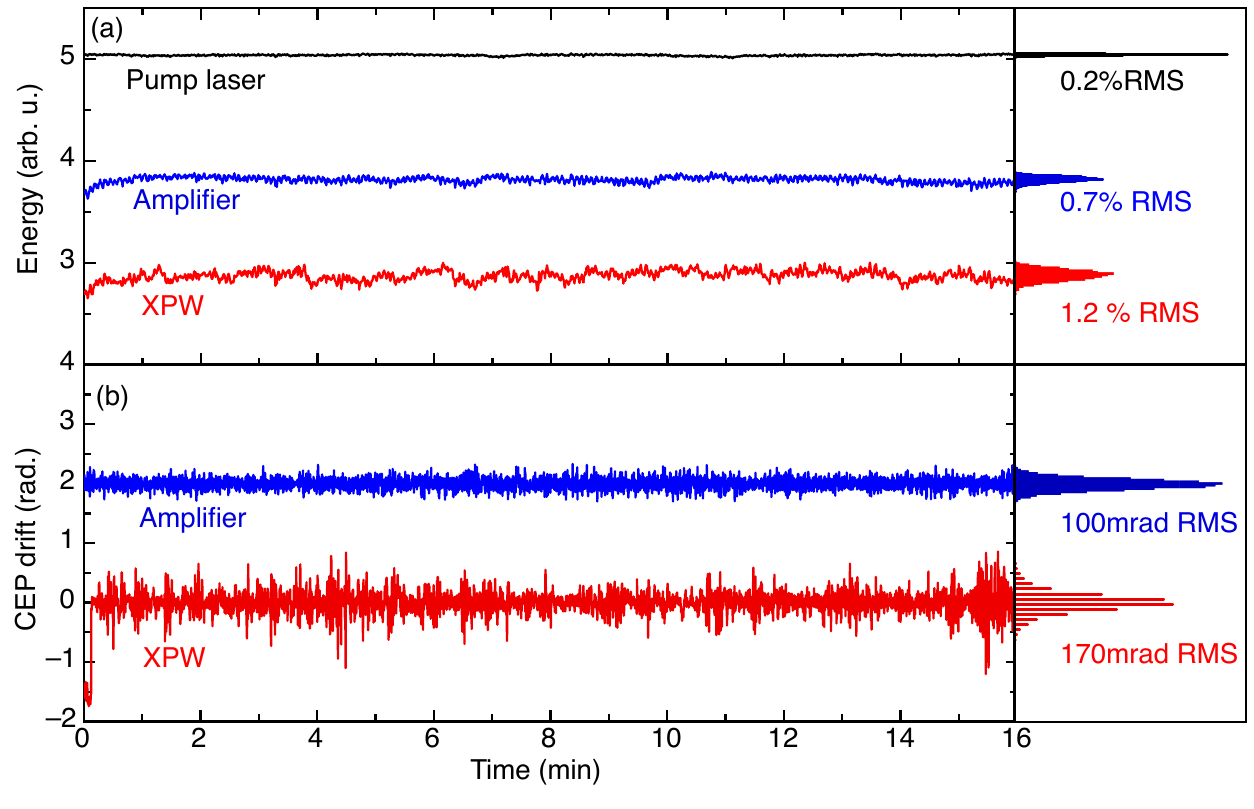
Figure 5. ( a ) Simultaneous measurements of energy fluctuations of the pump laser, amplified and filtered pulses over 16 min. Over one hour, typical rms energy deviations of the pump, amplifier and XPW pulses are 0.3%, 1% and 1.6% respectively; ( b ) Relative CEP drift with feedback control on the oscillator of the amplifier (measured after the XPW setup with no BaF crystal) and XPW pulses. Energy and CEP stability measurements have been done on 2 the same day under similar experimental